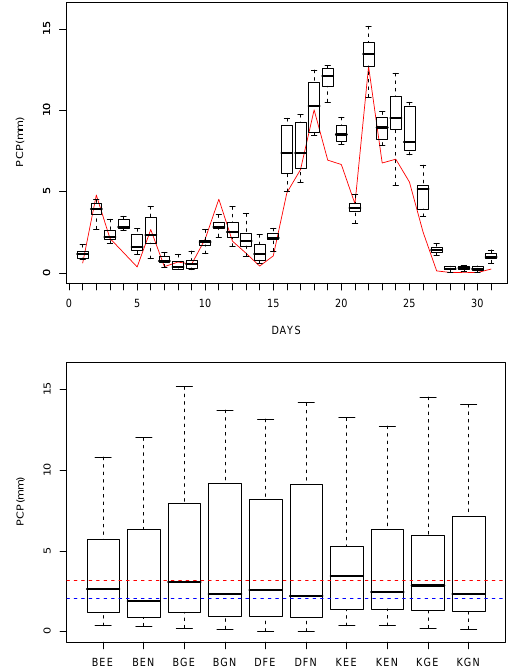
Fig. 6. Epsgram of the total daily precipitation, spatially averaged over the region, for (a) the ensemble system for each day of the period time with juxtaposition in solid line of the spatially averaged observed precipitation; (b) each ensemble member cited in the x- axis; dashed red and blue lines represent the mean and the median of the spatially averaged observed precipitation. Units are in